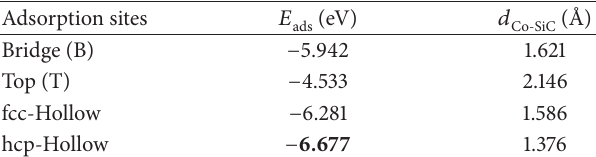
Table 2: The adsorption energies at different adsorptive sites for the Co adatom on